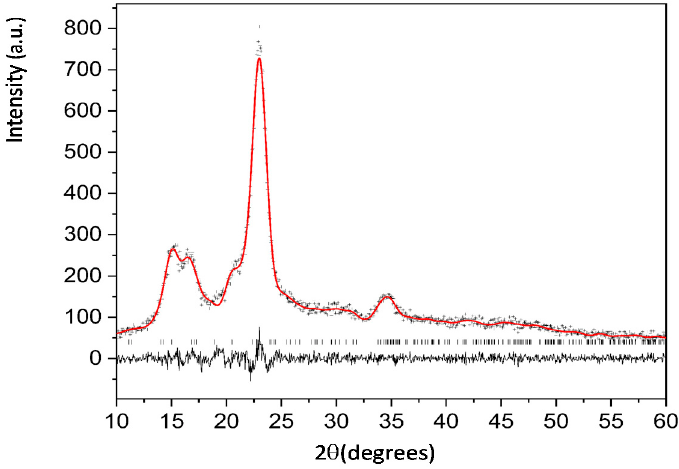
Figure 4. Rietveld analysis for the phase I β characterizing the CNC-CF. The ticks mark the reflections of the monoclinic crystal structure, and the red curve indicates the calculated fitting.